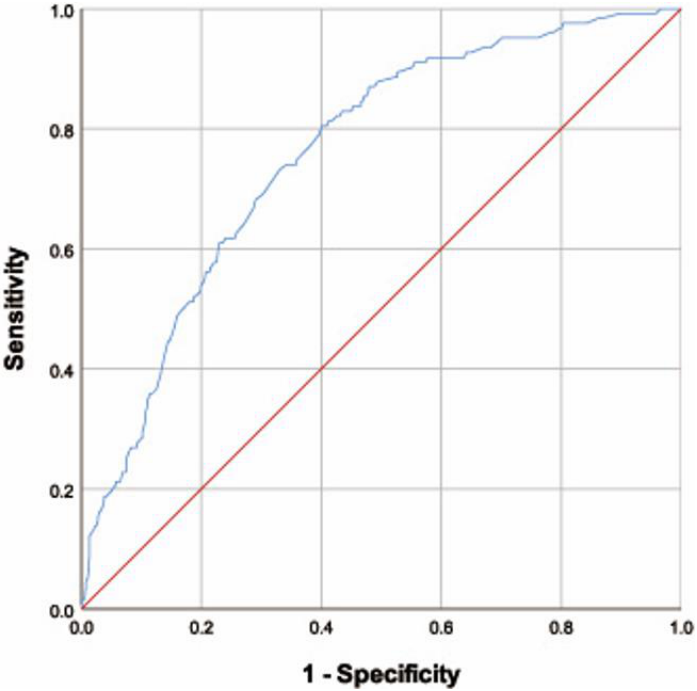
Figure 1. The receiver operating characteristic curve of the free sugars consumption and other covariates based on Model 4 of Table 3.